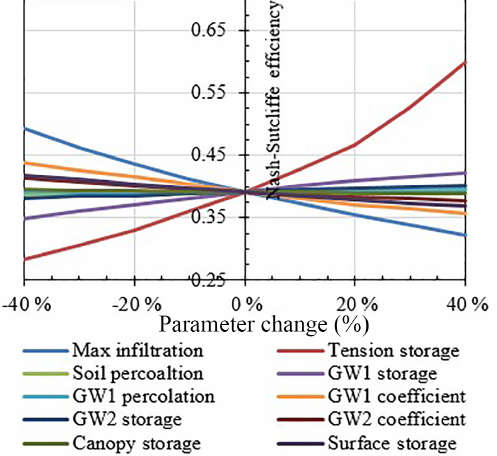
Figure 3. Nash-Sutcliffe Efficiency of the Model Output due to Per- cent Change in Parameter Values.